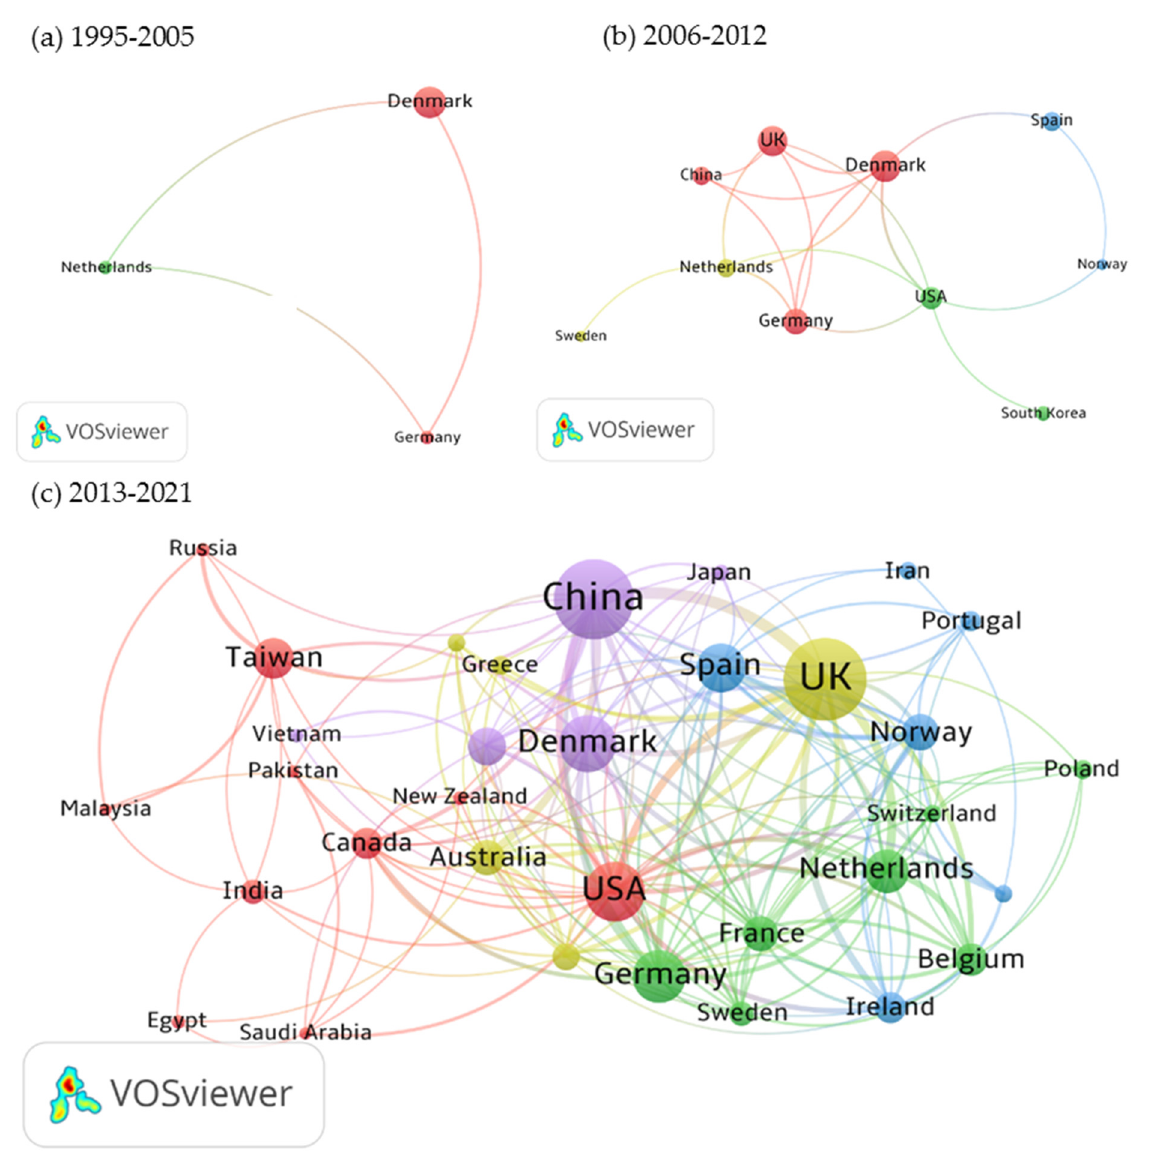
Figure 6. The keyword co-occurrence networks for offshore wind farm research: ( a ) first stage, ( b ) second stage, and ( c ) third stage.